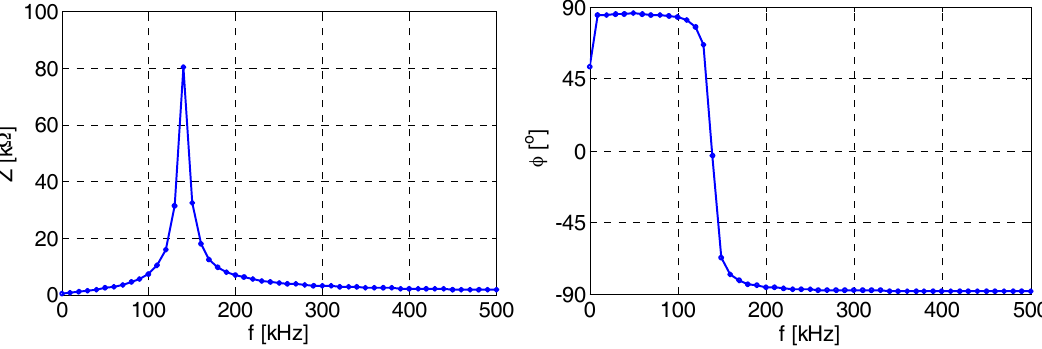
Figure 13. Frequency-dependent net impedance of the filter ( left ) and the phase shift measured between the supplying voltage and the input current ( right ).